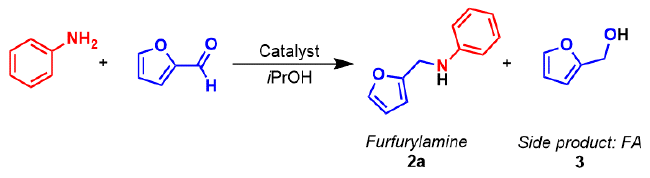
Scheme 2. Reductive amination between furfural and Table 2 . One-pot synthesis of furfurylamines: Optimization .